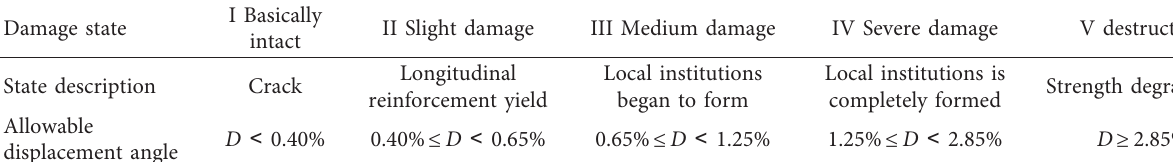
Table 3: Safety evaluation index of bridge pier.